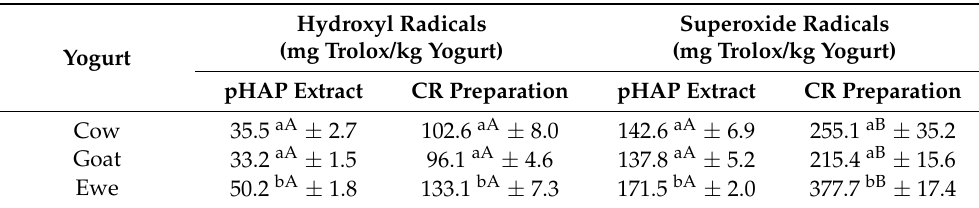
Table 5. Hydroxyl and superoxide anion radical scavenging activities of cow, goat and ewe yogurt preparations obtained by pH adjustment and precipitation (pHAP) and “Clarifying Reagent” (CR) 1 .